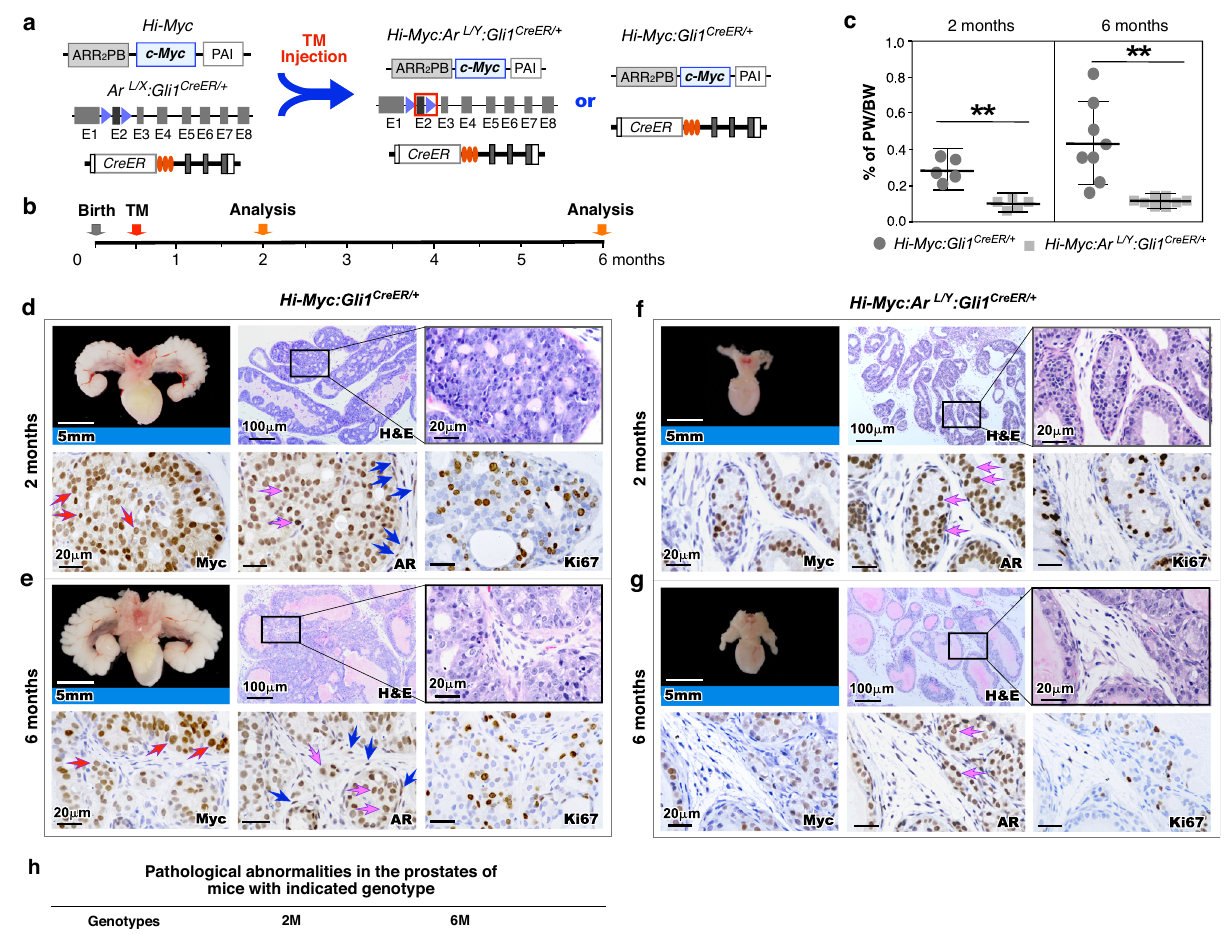
Fig. 2 | Deletion of AR in Gli1-expressing cells impairs prostate epithelial oncogenic transformation and growth in vivo. a Schematic for generating Hi- Myc:Gli1 CreER/+ and Hi-Myc:Ar L/Y :Gli1 CreER/+ mice. b Schematic of experimental timeline for tamoxifen (TM) injection and analysis. c Ratio of prostate weight (PW) versus whole body weight (BW) as percentages of 2-month-old mice (left panel; n =5 biological replicates) and 6-month-old mice (right panel; n =8 biological repli- cates). Data are represented as mean±SD of indicated biological replicates. Two- sidedStudent ’ s t test, ** p <0.01.Sourcedataandtheexact p valuesareprovidedasa